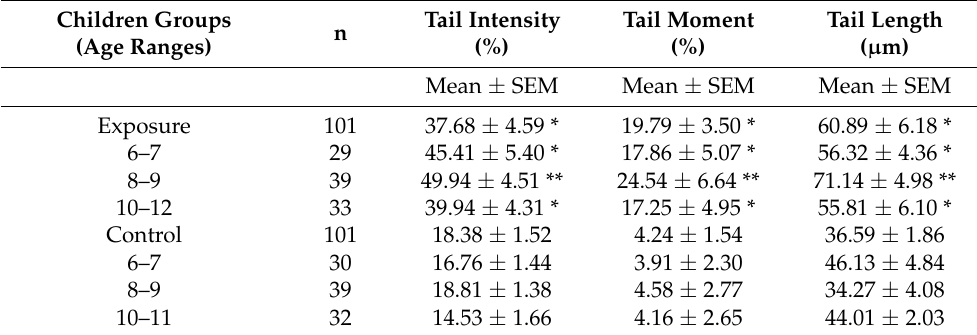
Table 2. Mean of the genotoxic parameters in buccal mucosa cells in the (El Fraile, Taxco de Alarc ó n)- exposure and (Chilpancingo)-control groups in Guerrero State,